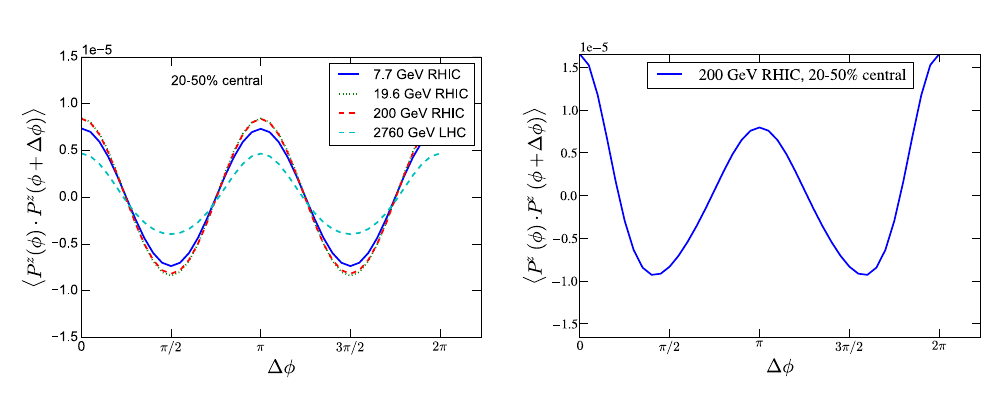
Figure 2. Covariance of polarization components in beam direction, for pairs of midrapidity Λ separated by azimuthal angle ∆ φ in transverse momentum space. Left panel: results with averaged initial state from UrQMD ( √ s NN = 7.7,...,200 GeV Au-Au) and Monte Carlo Glauber ( √ s NN = 200 Au-Au, 2760 GeV Pb-Pb). Right panel: event-by-event hydrodynamic calculation with UrQMD initial state for Au-Au collisions at √ s NN = 200